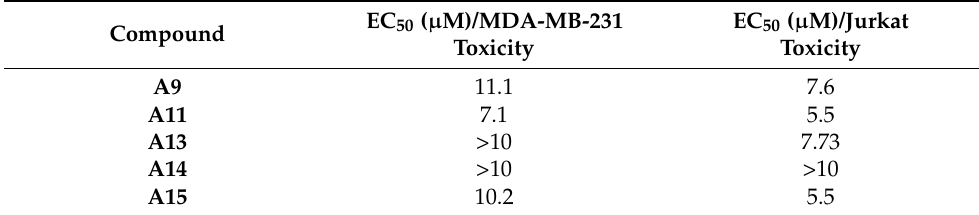
Table 3. Cytotoxic of inhibitors of the PD-1/PD-L1